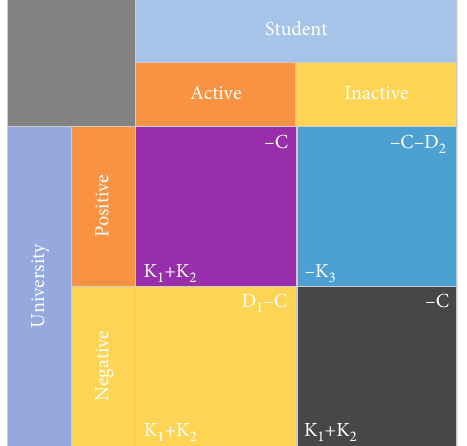
Figure 4: The game matrix grid between student and